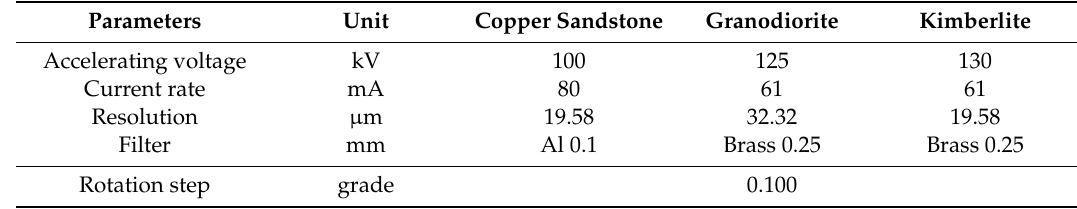
Figure 2. Basic principles of CT: ( a ) scanning of the sample in X-ray beam, ( b ) mathematical transformation of the shadow vertical projections into a series of horizontal sections of the object, ( c ) creation of three-dimensional images of the sample. Table 2. The shooting parameters set for scanning the samples.